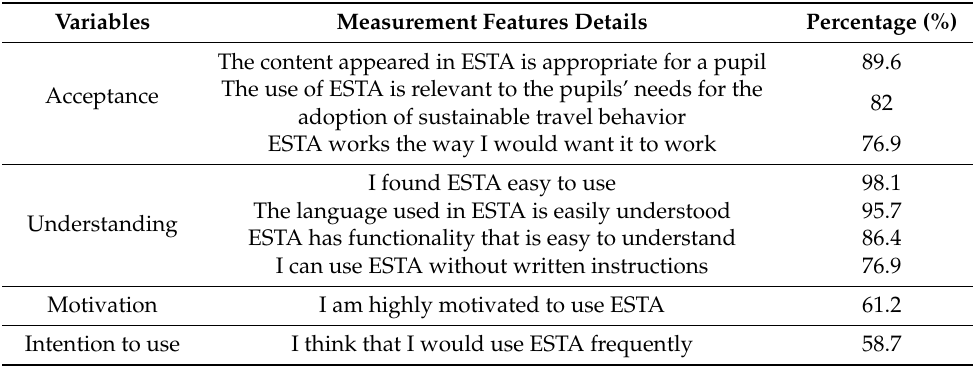
Table 4. Overall evaluation of